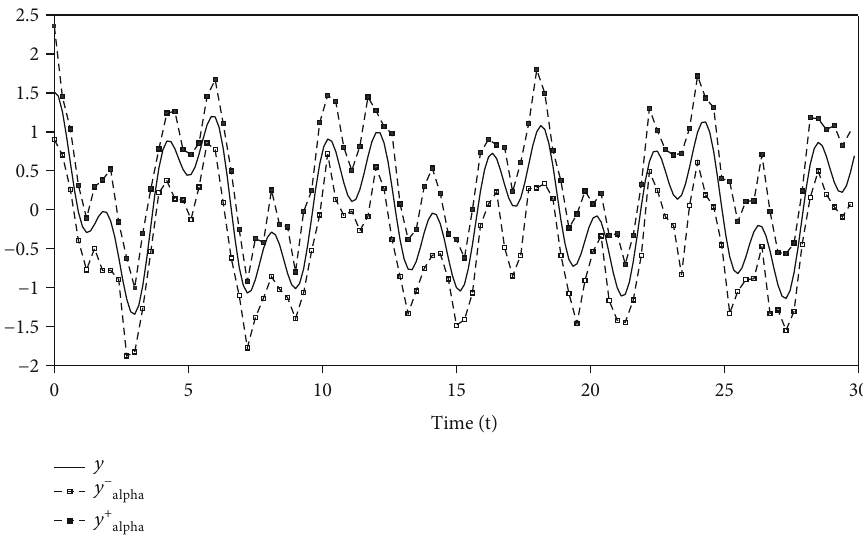
− t Þ , y data+ t Þ(cid:2) , with the left-end y data α ð α ð